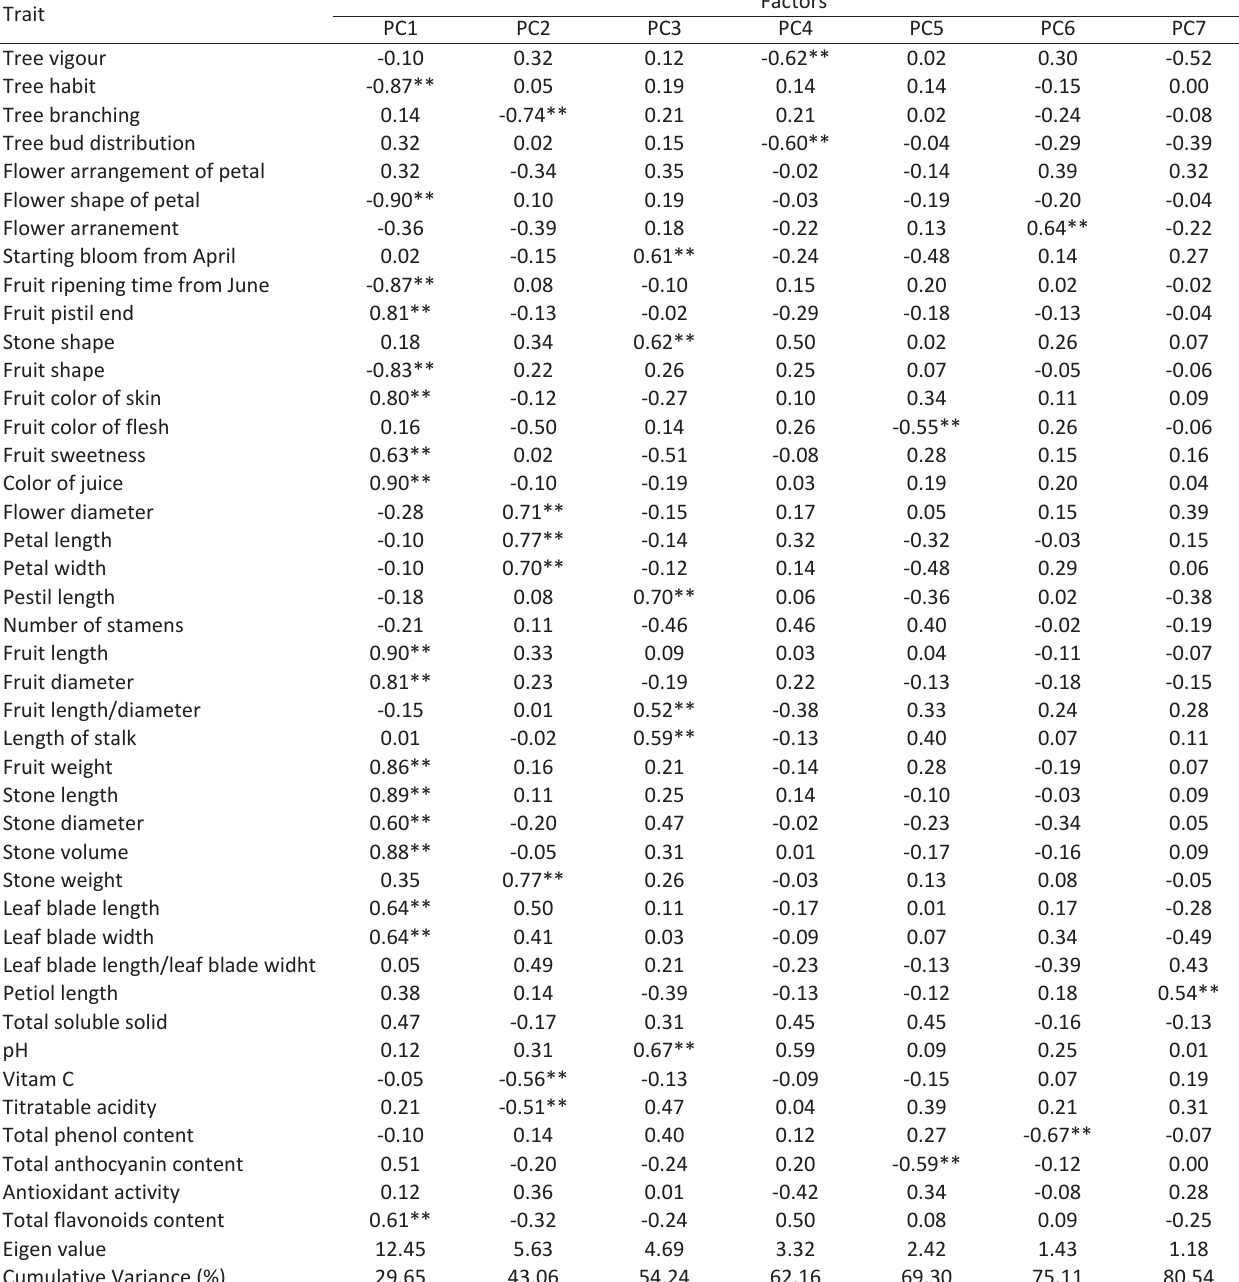
Table 3 - Eigen values and cumulative variance for seven major factors obtained from principal component analysis (PCA) and traits within each factor for sour cherry genotypes Trait